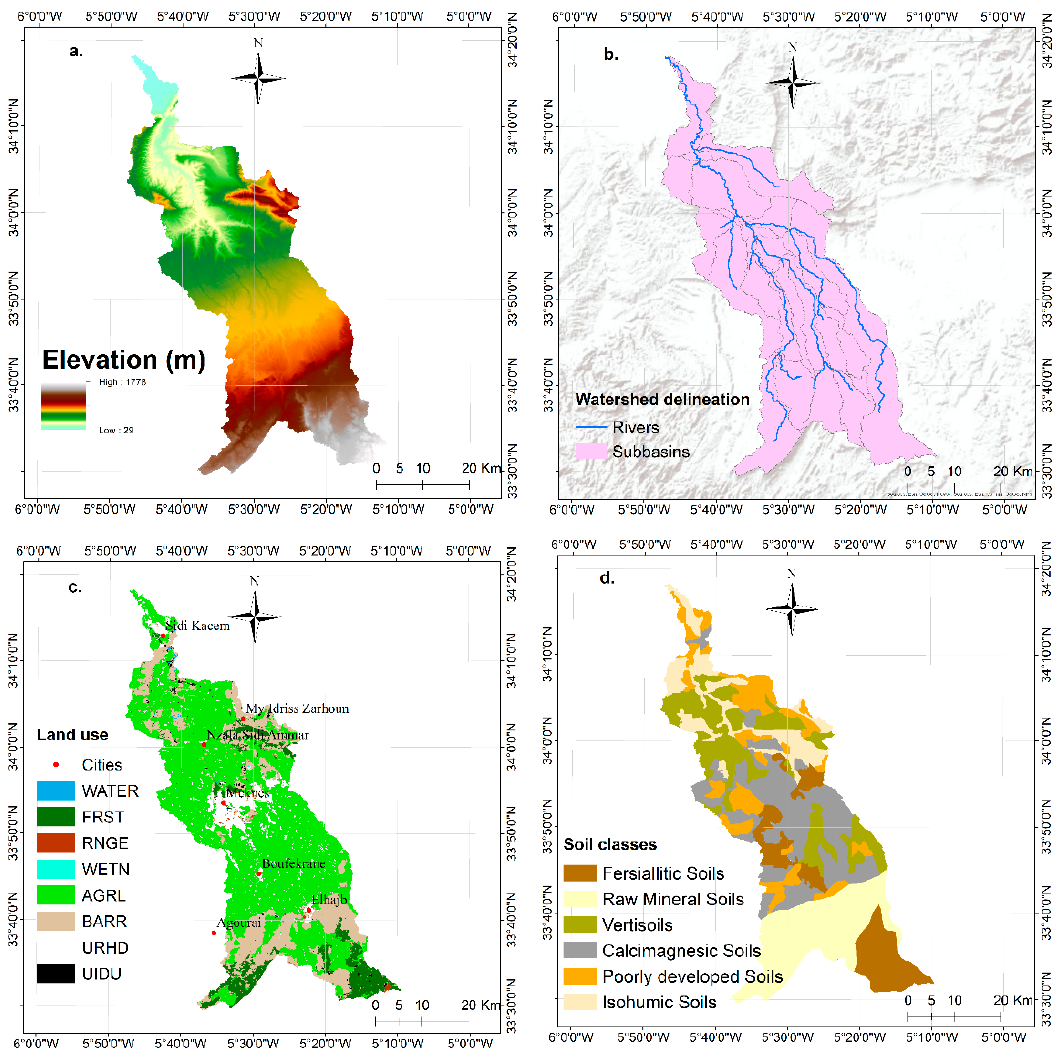
Figure 7. Spatial distribution of SWAT parameters: ( a ) Elevation (m), ( b ) Watershed delineation, ( c ) Land use and ( d ) Soil classes maps.